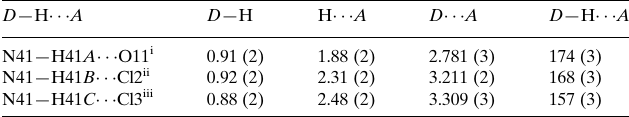
Hydrogen-bond geometry (A˚ , (cid:3)